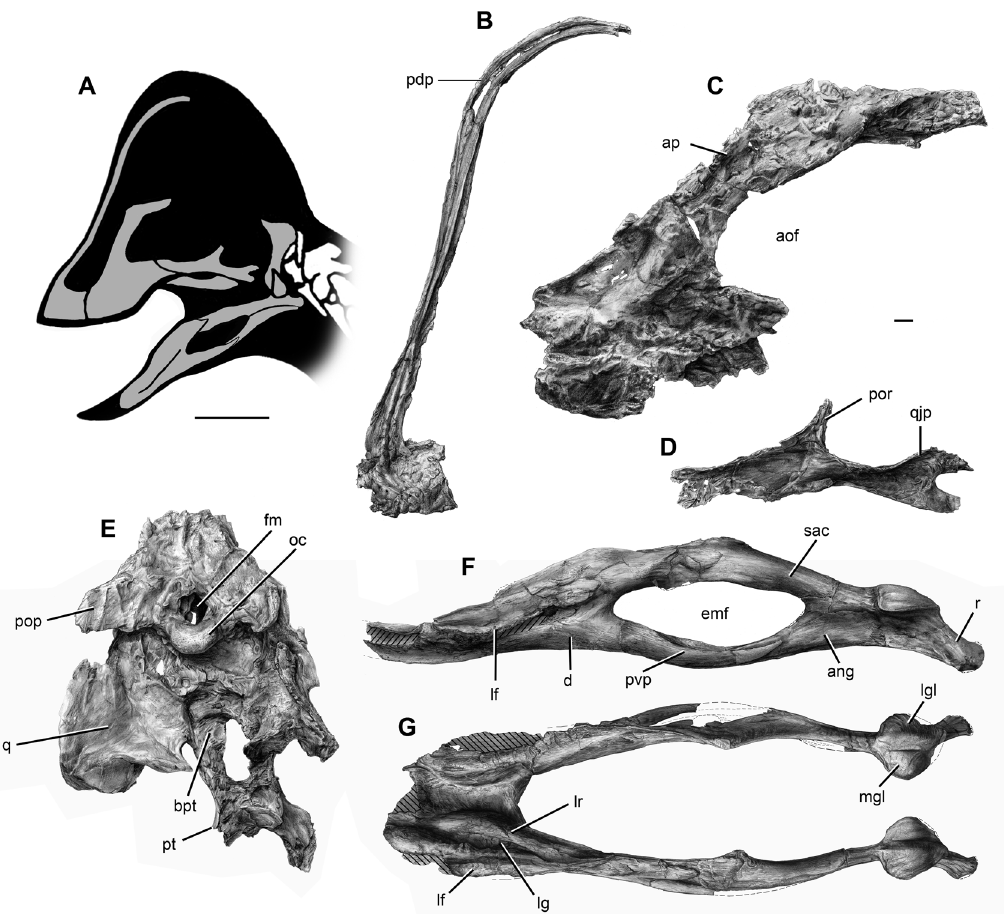
Figure 2. Craniomandibular skeleton of Anzuwyliei gen. et sp. nov. ( A ) Reconstructed skull and mandible in left lateral view, with preserved bones in gray. ( B ) Left premaxilla of CM 78001 in lateral view. ( C ) Left maxilla of CM 78001 in lateral view. ( D ) Left jugal of CM 78001 in lateral view. ( E ) Braincase with articulated quadrates and pterygoids of CM 78001 in posterior view. Reconstructed mandible of CM 78000 in left lateral ( F ) and dorsal ( G ) views (hatching indicates broken areas, dashed lines indicate restoration). Abbreviations: ang, angular; aof, antorbital fenestra; ap, ascending process; bpt, basipterygoid process; d, dentary; emf, external mandibular fenestra; fm, foramen magnum; lf, lateral flange; lg, lateral groove; lgl, lateral facet of mandibular glenoid; lr, lingual ridge; mgl, medial facet of mandibular glenoid; oc, occipital condyle; pdp, posterodorsal process; pop, paroccipital process; por, postorbital process; pt, pterygoid; pvp, posteroventral process; q, quadrate; qjp, quadratojugal process; r, retroarticular process; sac, surangular–articular–coronoid complex. Scale bars =10 cm in A; 1 cm in